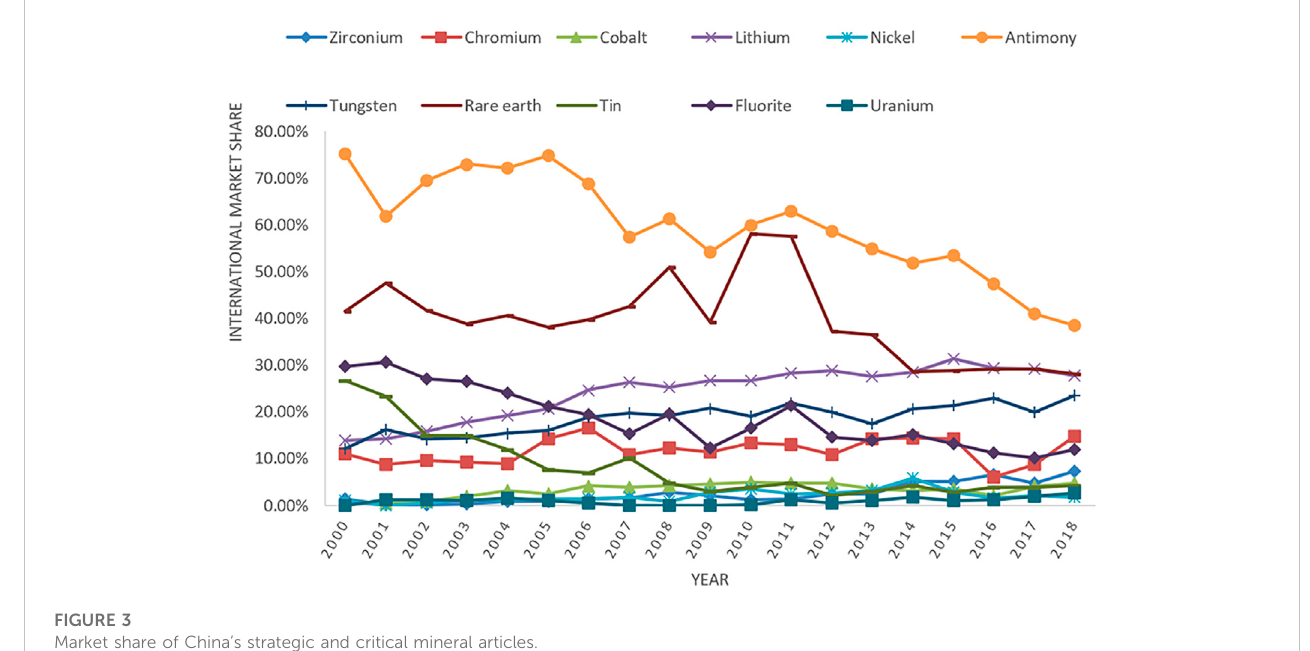
FIGURE 3 Market share of China ’ s strategic and critical mineral articles.